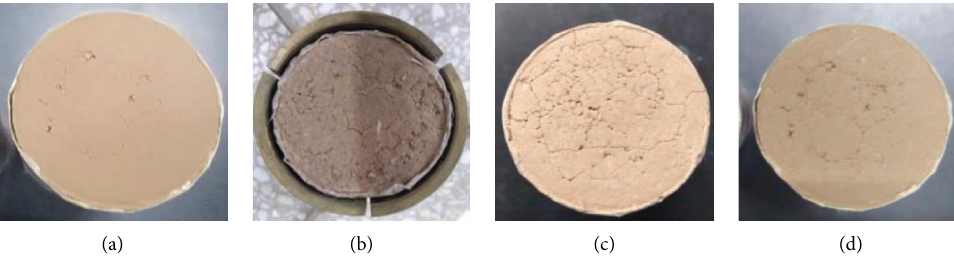
Figure 10: Surface crack characteristics of samples with diferent cyclic paths after the 6th W - D cycle dehumidifcation.